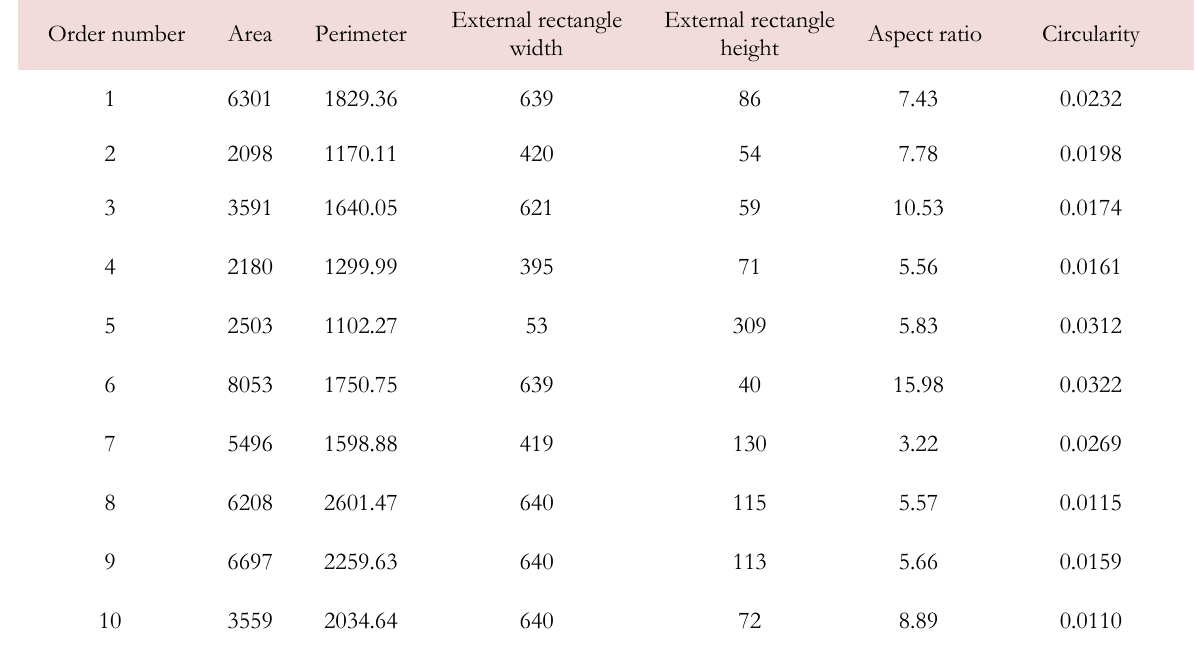
Table 1: Result of the crack image’s characteristic quantities (unit: